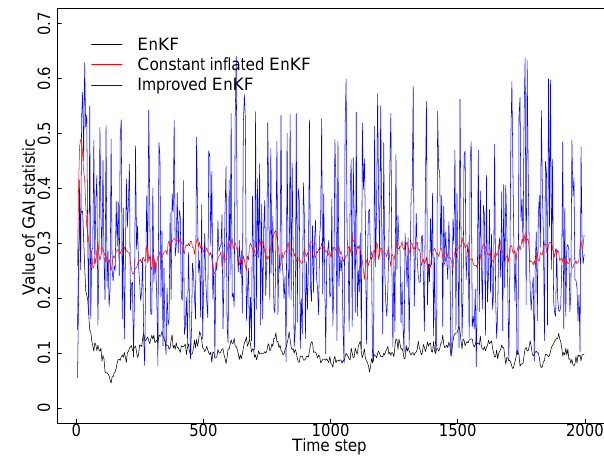
Figure 2. Time series of the estimated inflation factors by minimiz- ing the GCV function. The median of the estimated inflation factors is 1.88.